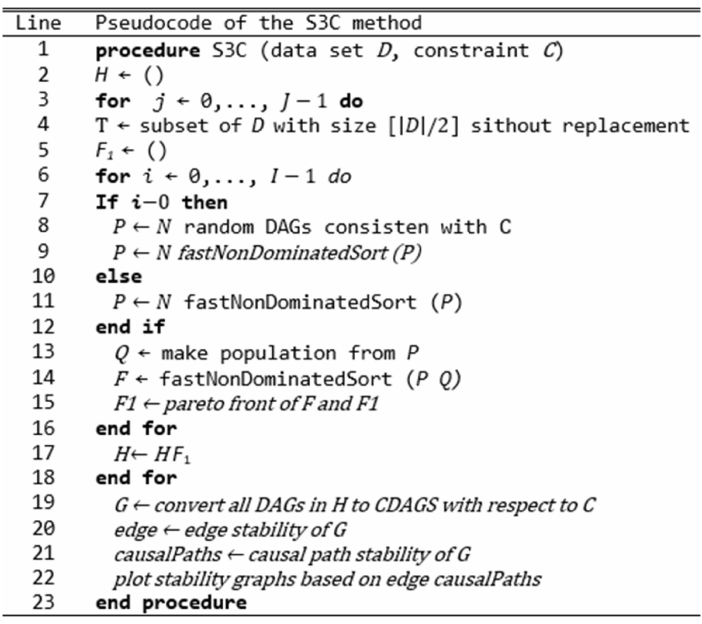
Algorithm 1. The Pseudocode of S3C